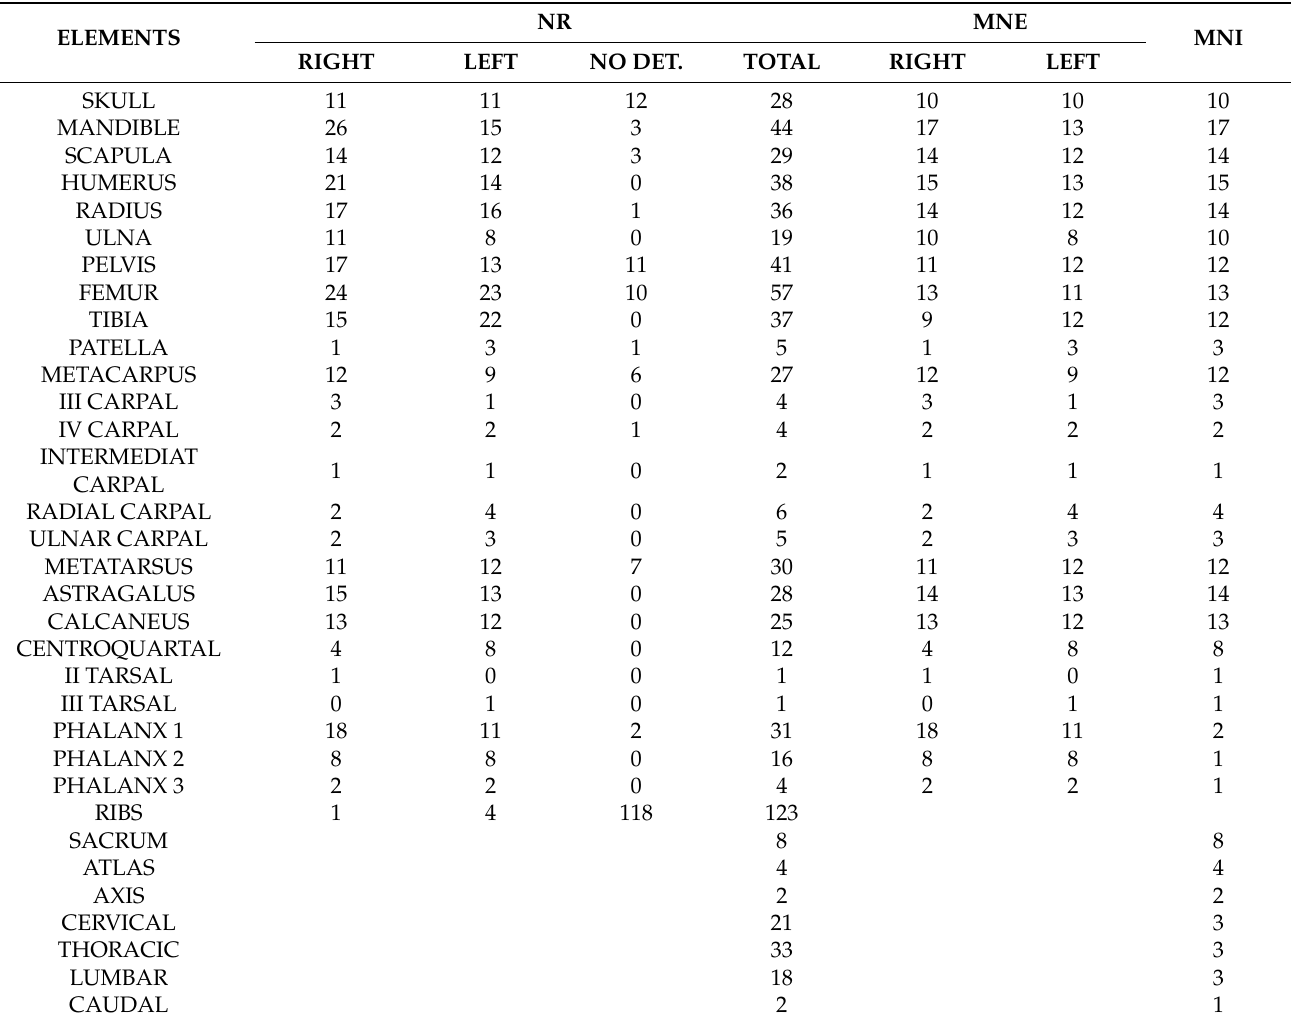
Table 2. Number of Identified Remains (NISP), Minimum Number of Elements, and Minimum Number of Individuals for cattle elements recovered in the Vilauba